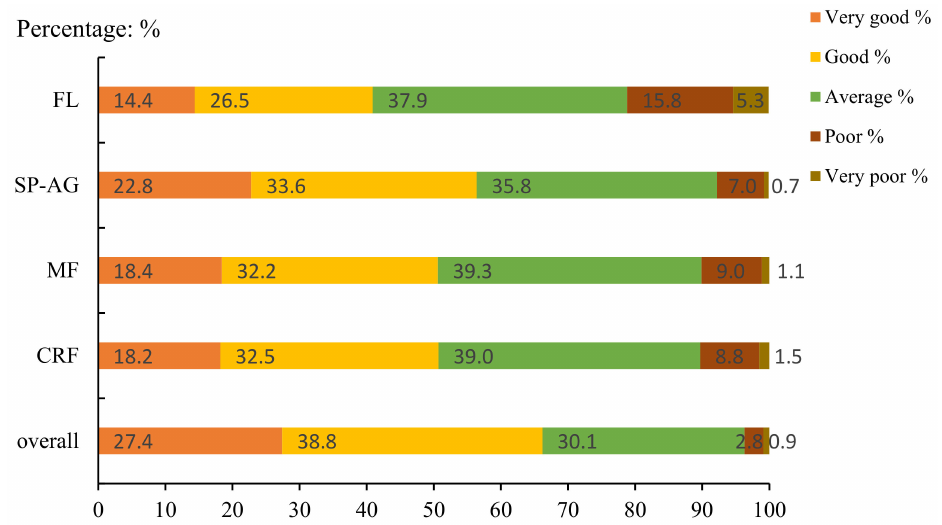
Figure 2. Distribution of responses by categories of self-reported PF in adolescents (CRF = cardiores- piratory fitness; MF = muscular fitness; SP–AG = speed and agility; FL =